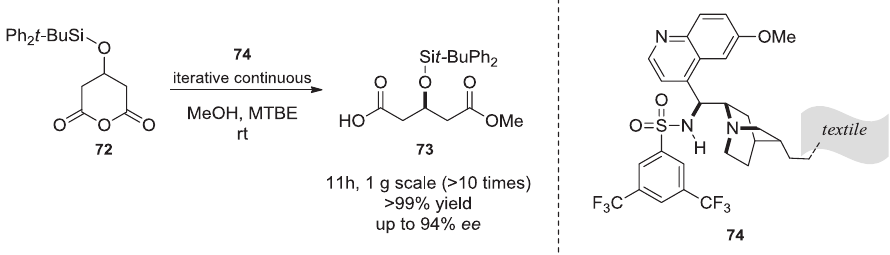
Figure 18. ‘ OrganoTexCat ’ for the desymmetrization of silylated glutamic anhydride, from Ref. [94, 95]. The reaction is performed under continuous conditions, in a fl ow reactor packed with 74.